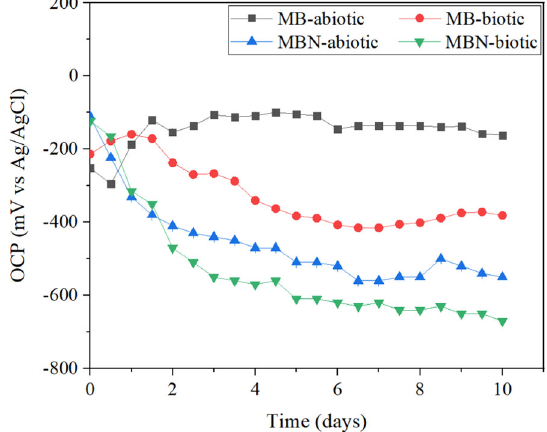
Fig. 7 OCP measurements of creviced coupons taken for 10 days in different test media. OCP vs time for creviced 304 stainless steel coupons immersed in MB and MBN test media under abiotic and biotic